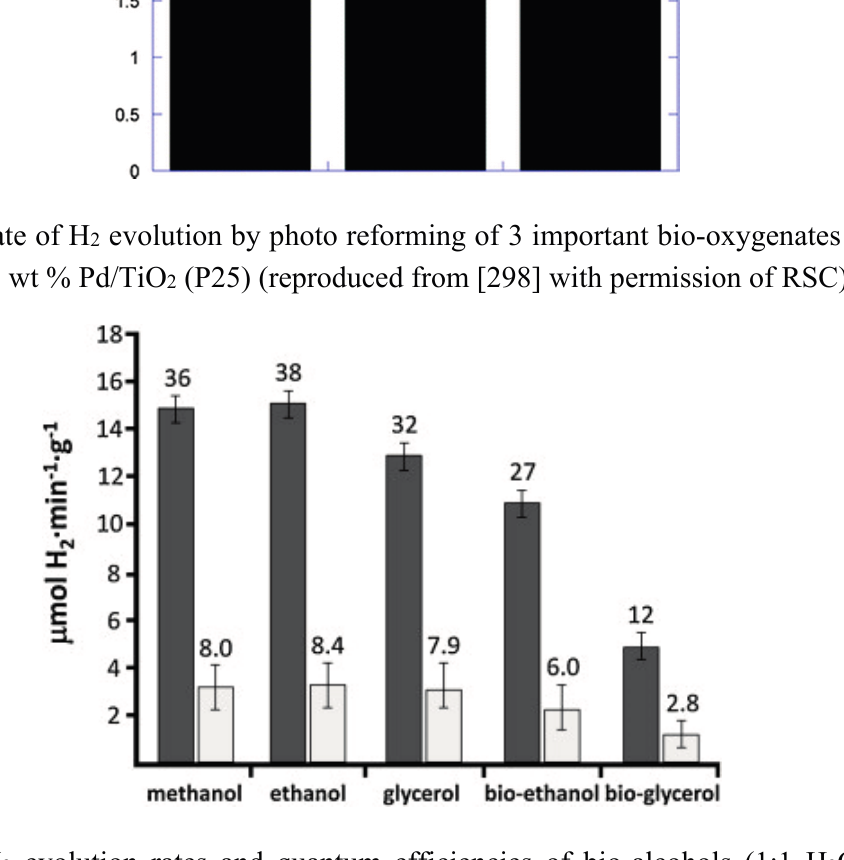
Figure 25. H 2 evolution rates and quantum efficiencies of bio-alcohols (1:1 H 2 O) in a catalytic wall reactor (dark) or a slurry reactor (light) over 1 wt % Au/TiO 2 . (reproduced from [297] with permission of